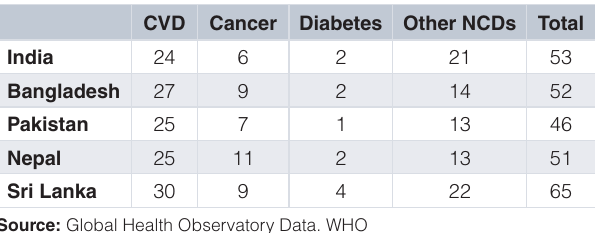
Table 3. Proportional mortality from NCDs in South Asian in 2008 (% of total deaths, all